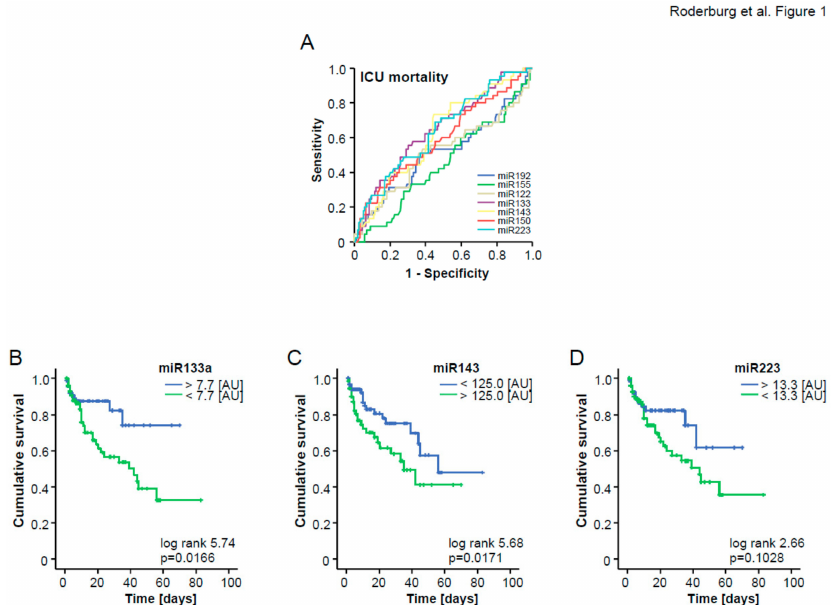
Figure 1. ( A ) ROC analysis comparing all seven single miRNAs at admission for ICU mortality. ( B – D ) Optimal cuto ff s were calculated for miR-133a, miR-143, and miR-223 using Youden’s index to discriminate between ICU non-survivors and survivors. Kaplan–Meier curves with miR-133a, miR-143, and miR-223 as single biomarker are displayed.